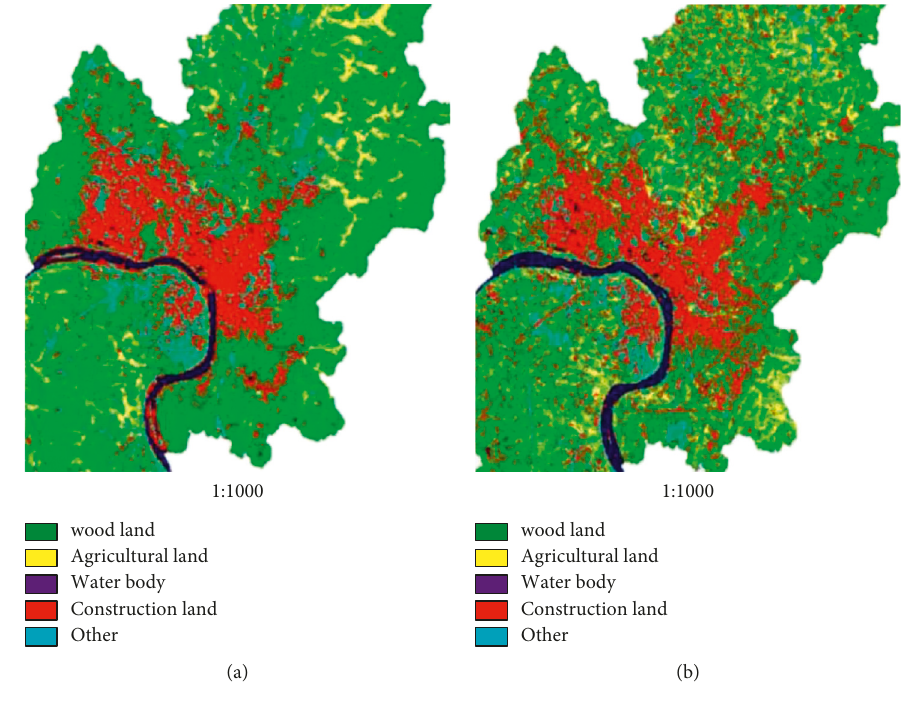
Figure 4: Regional land coverage. (a) 2020 and (b) Table 2: Dynamic changes of land use types from 2020 to 2021/hm 2 .